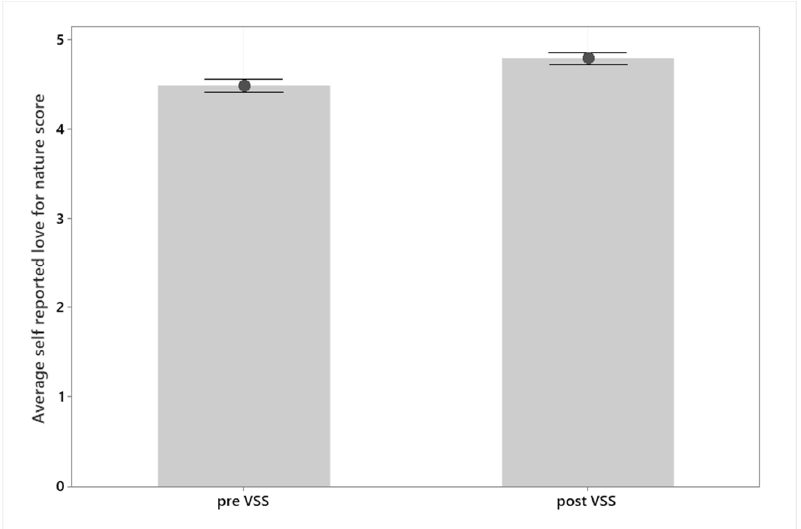
Figure 5. Self-reported love for nature before and after the Virtual Summer School (VSS), five representing the highest level. A significant increase is observed ( p = 0.001, Hedges’ g = 0.44). Error bars represent the standard error of the mean.